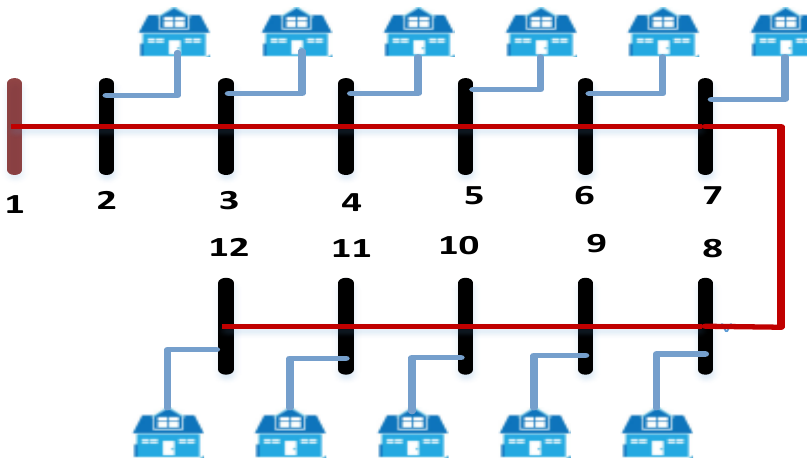
Figure 2. The topology of the studied micro-grid (MG). Table 1. The specification of the 12-bus system.